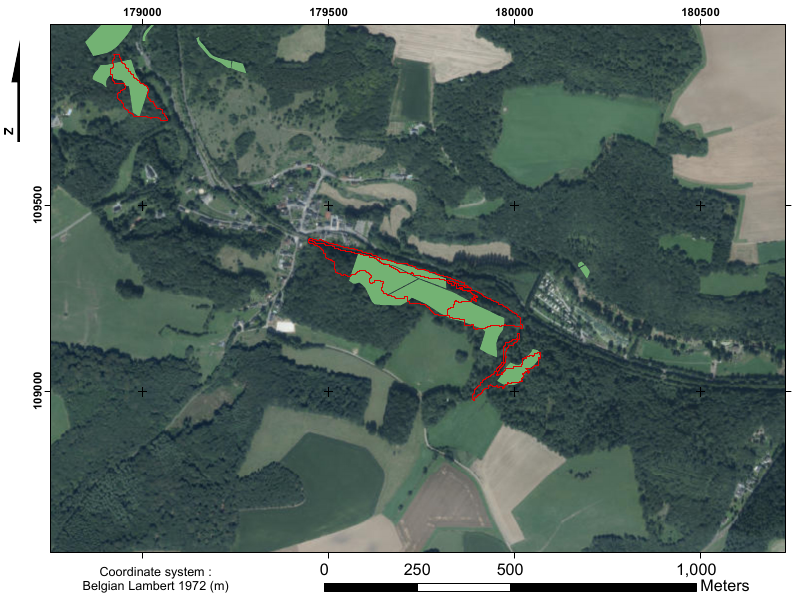
Figure 5. Divergences of delineation of ravine forest in the Natura 2000 database (green polygons) and the automated segmentation (red